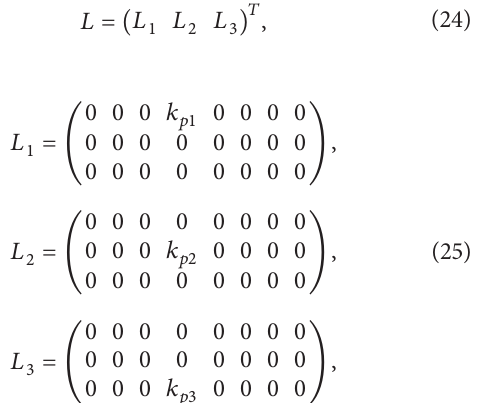
dynamics produced by the model. The value of this ratio can be altered by adjusting 𝐴 . The connectivity constant 𝐾 𝑙𝑗 can be used to adjust the strength of coupling between population 𝑙 and population 𝑗 . This constant may also be used to inter- connect populations in different ways. Consider a